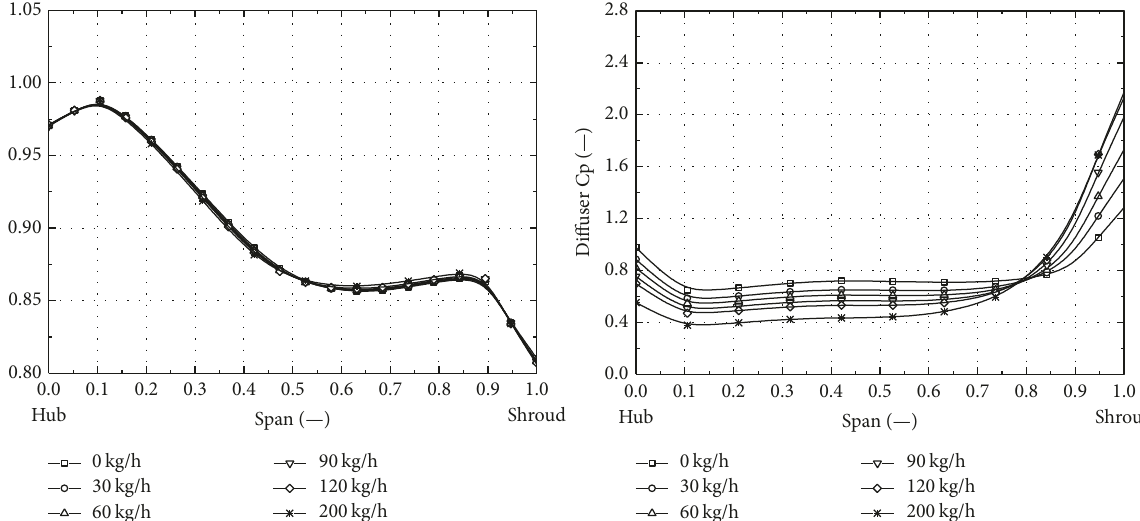
Figure 16: Characteristics of the impeller and the diffuser.